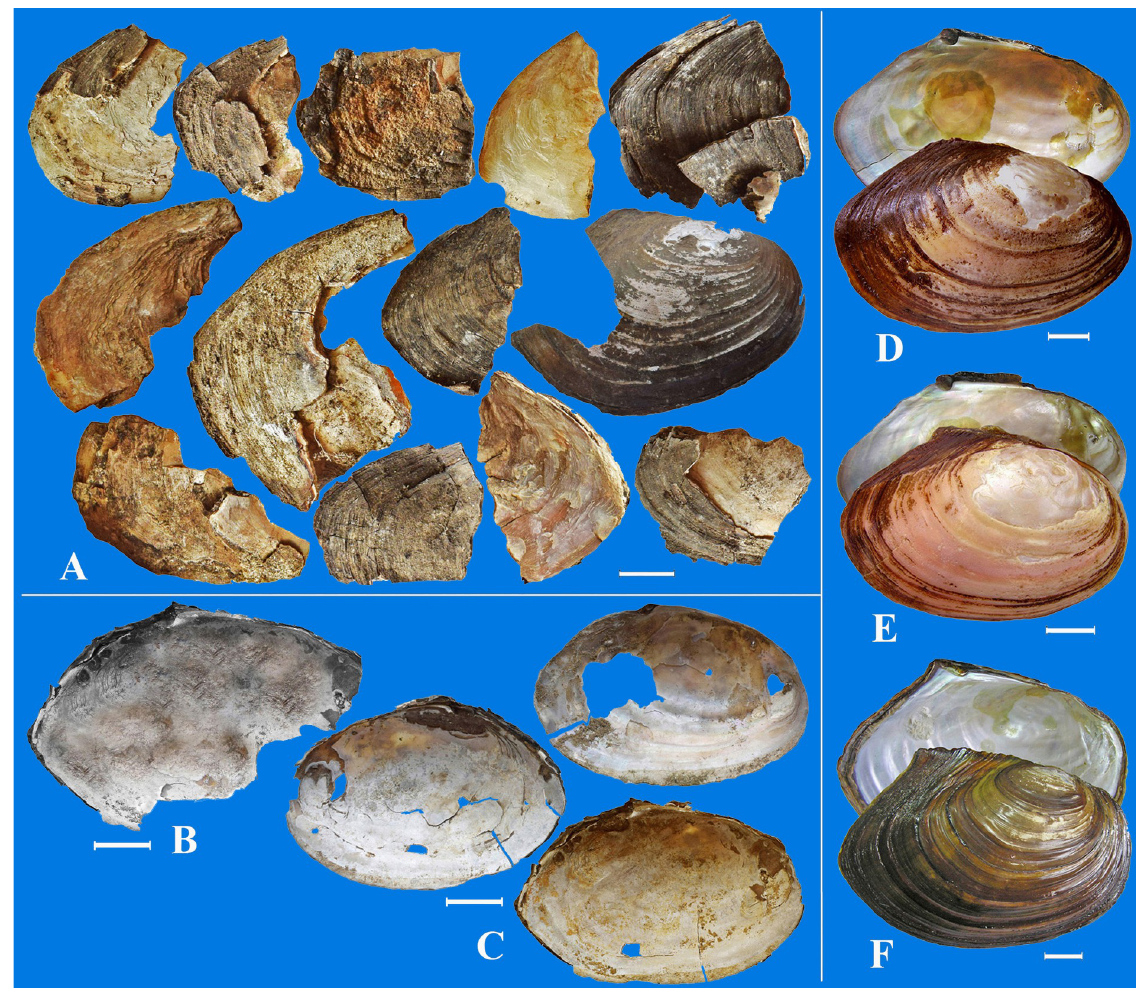
E–from the Nercha River and F–from the Ingoda River. Scale bar 2